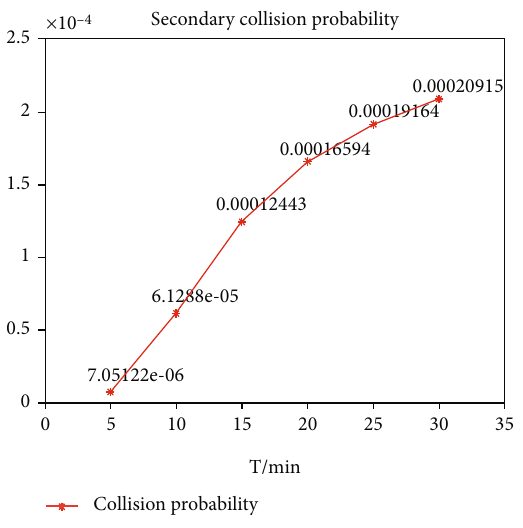
Figure 19: Secondary collision